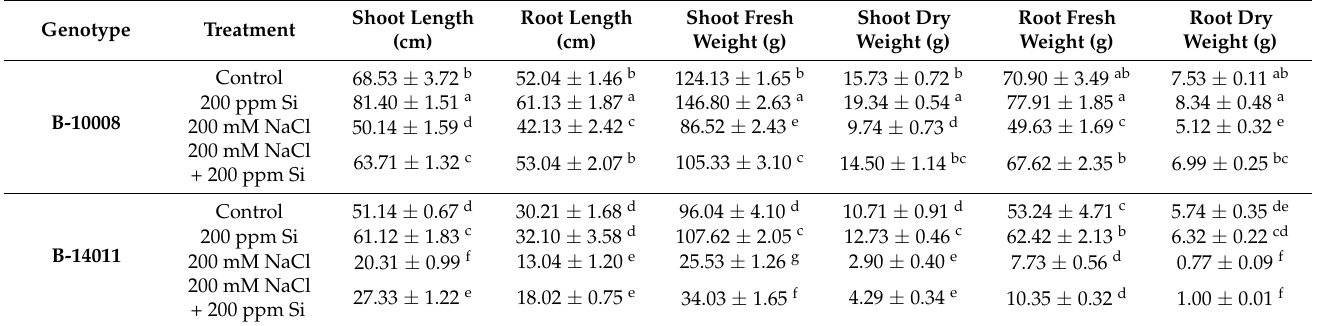
Table 1. Morphological attributes of barley genotypes modulated by rooting application of silicon under salinity stress.